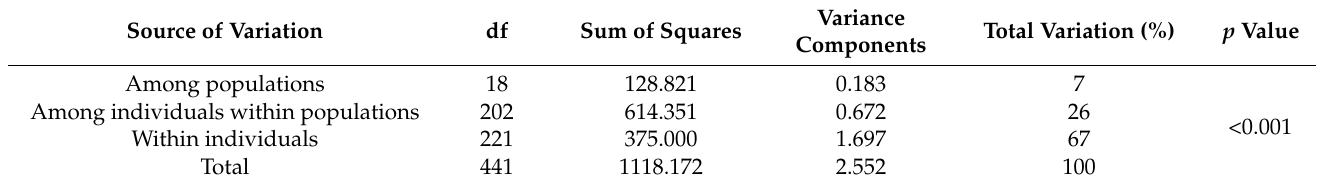
Table 4. Analysis of molecular variance (AMOVA) for 19 populations of ancient P. orientalis .